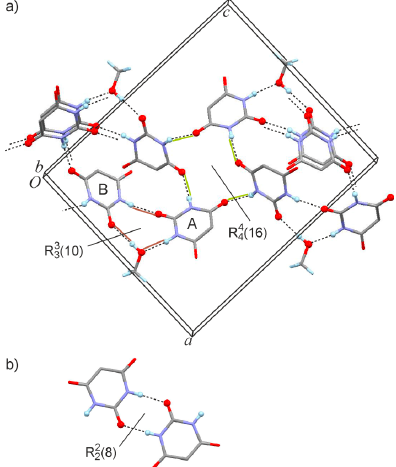
Figure 2. ( a ) N–H ∙∙∙ O=C, N–H ∙∙∙ O(MeOH) and (MeOH)O–H ∙∙∙ O=C-bonded layer structure of 1MH . O and H atoms involved in hydrogen bonding are drawn as spheres and hydrogen bonds are drawn as dashed lines. Br atoms are omitted for clarity; ( b ) R2 2(8) ring motif involving the C2 carbonyl functions of two barbiturate molecules, found in the orthorhombic and monoclinic polymorphs of 1 . The diagram in Figure 3 is based on the topological net of the HBS of 1MH , generated in the manner described by Baburin & Blatov [20]. The nodes represent molecules, and links between these nodes represent H-bond connections. As proposed by Hursthouse et al. [21], arrows have been added to indicate the type and direction of each H-bond interaction. Only this latter modification